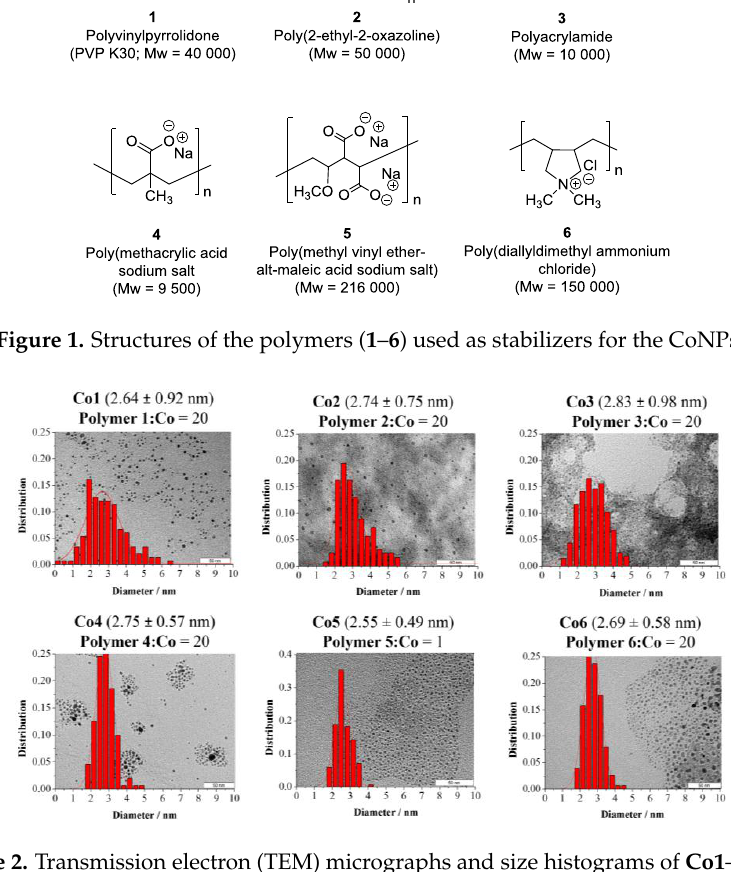
Figure 2. Transmission electron (TEM) micrographs and size histograms of Co1 – 6 NPs.